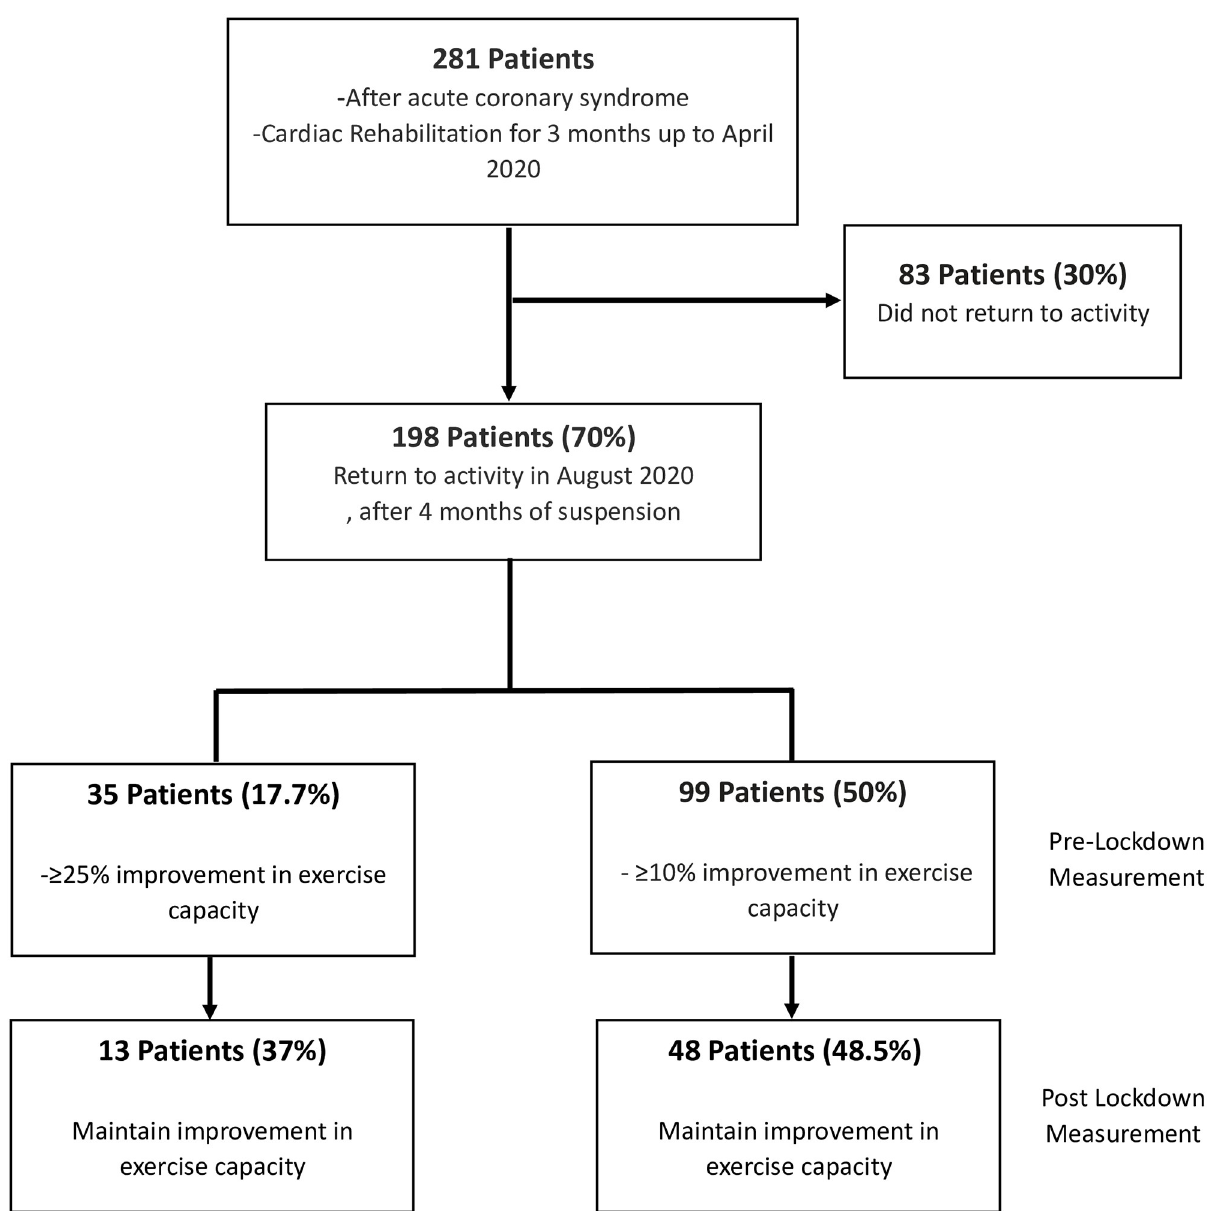
Fig 2. Flow chart of the study participants including changes in exercise capacity (n =